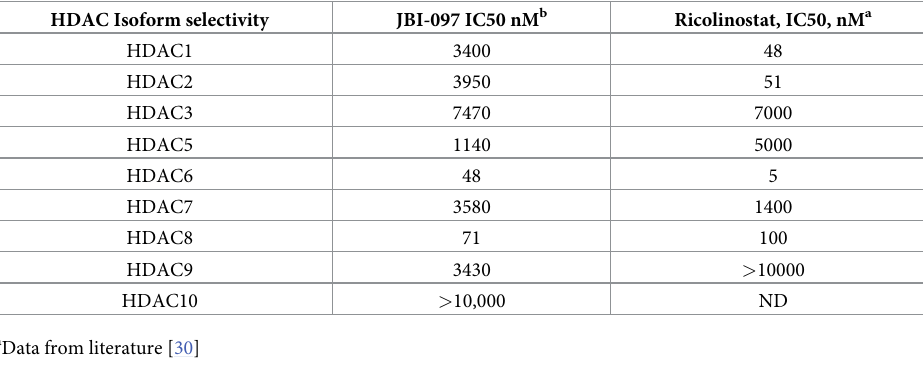
Table 1. HDAC Isoform Selectivity of